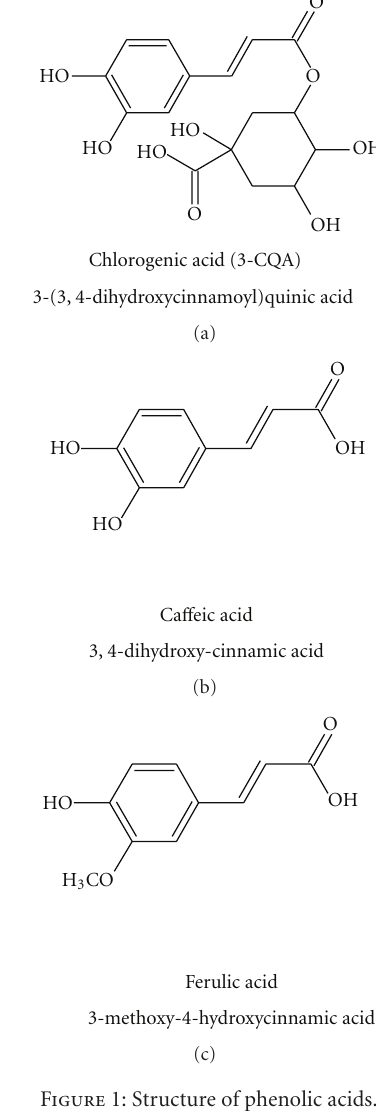
Figure 1: Structure of phenolic